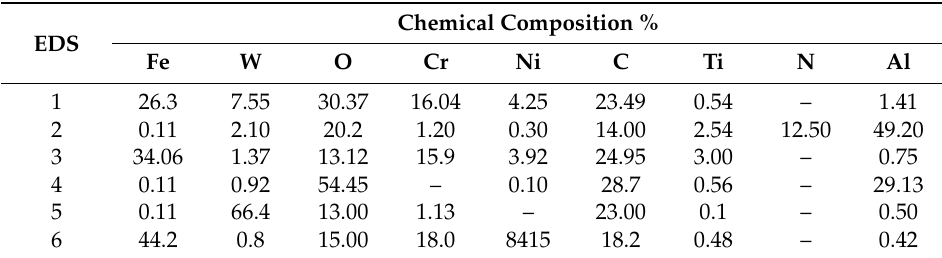
Table 4. EDS analysis associated with cutting tools in Figures 7–9.